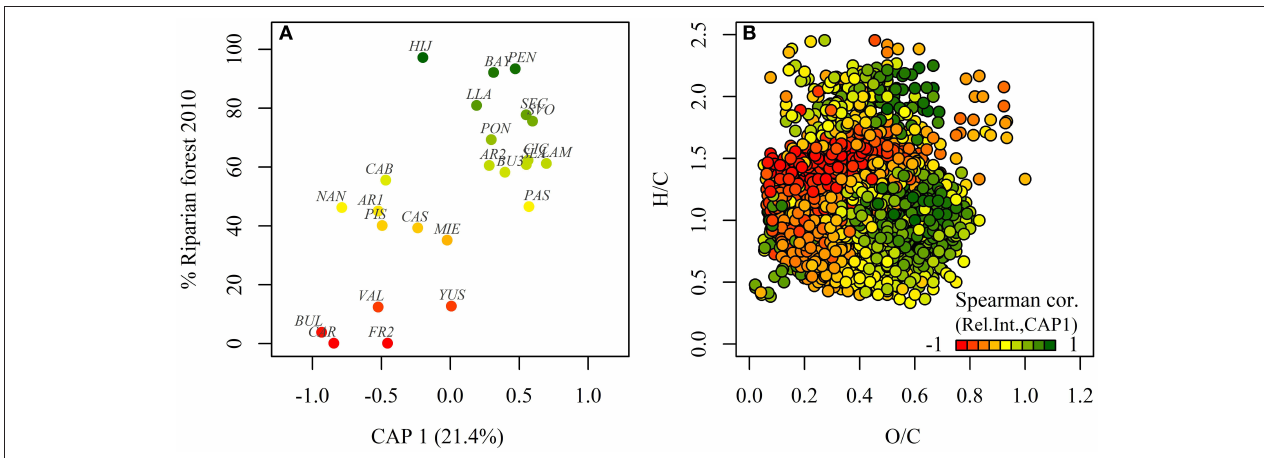
FIGURE 2 | Changes of DOM composition assessed by canonical analysis of principal coordinates (CAP) based on Bray–Curtis dissimilarity of DOM molecular composition are driven by a major constraint: current riparian forest cover, which defines the canonical axis 1 (CAP 1). (A) Relationship between CAP 1 and current riparian forest cover. The streams (stream codes are shown, Supplementary Material 1 ) are colored according to current riparian forest cover. (B) A Van Krevelen diagram shows the major changes in DOM composition associated with CAP 1. Point color indicates correlation of relative intensities of individual compounds with the canonical axis across all sampled streams. Red/green compounds decrease/increase in relative intensity with riparian forest cover. Compounds are plotted in random order.